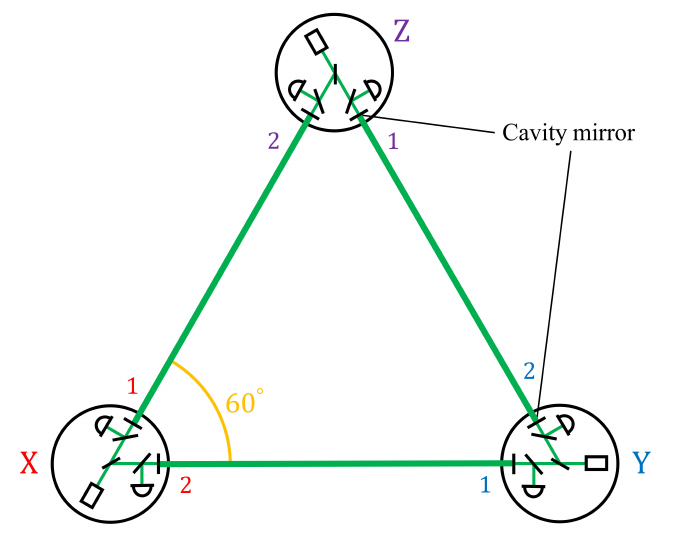
Figure 2. Schematic configuration of one cluster in DECIGO. X , Y , and Z denote the three interfer- ometers in a cluster. Additionally, 1,2 represent the arms in each